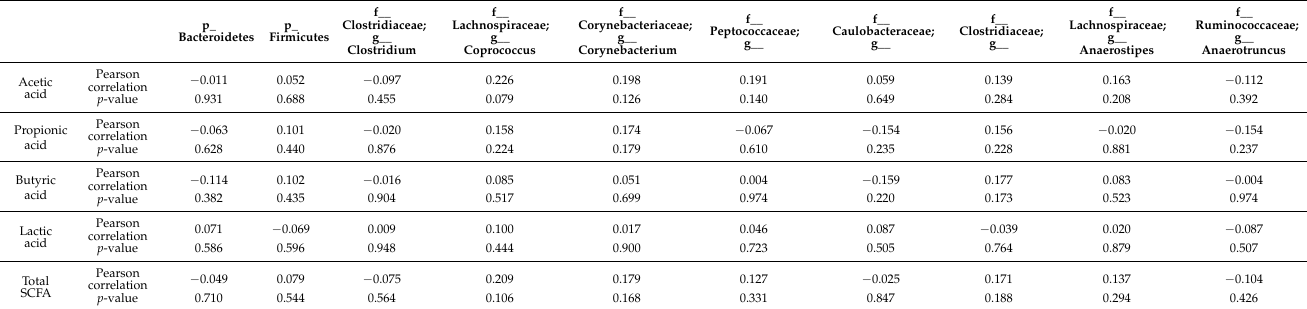
Table A1. Correlation between bacteria with altered abundance and short-chain fatty